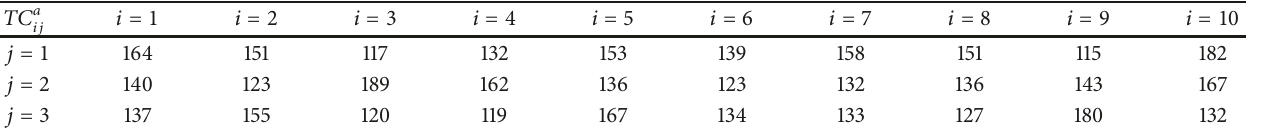
Table 4: Parameters of the base case, transportation unit cost from supplier 𝑖 to plant 𝑗 .